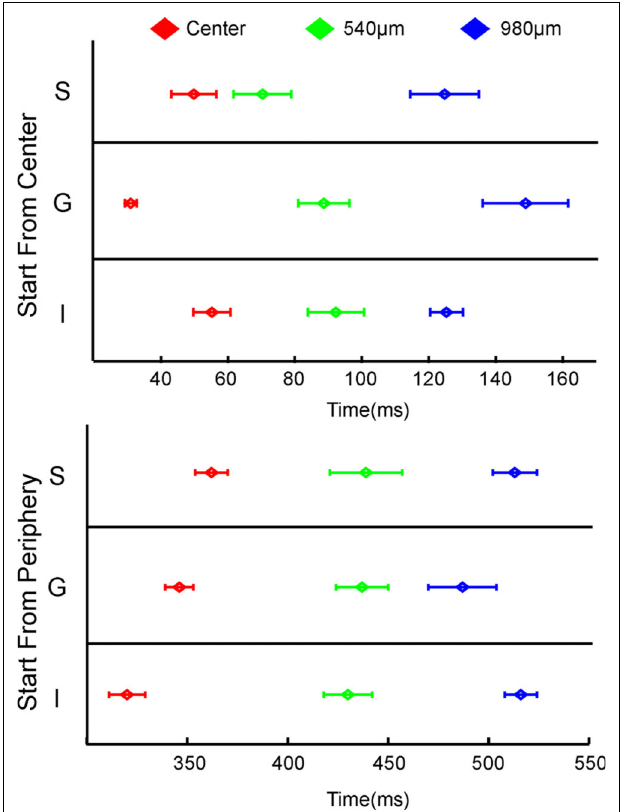
FIGURE 3 | Statistically signifi cant laminar onsets of MUA at three cortical sites. At each site along the 17/18 border, the statistically defi ned onset of fi ring for the fi ve leads corresponding the supragranular (S) layers, the three leads corresponding to the granular (G) layers and the fi ve leads corresponding to the infragranular (G) layers were pooled to give a mean S, G, and I onset for each animal. The mean and SEM for all 11 animals are shown. Note that these values were taken from both upward and downward movement conditions, i.e. the data points at 540 µm are taken from recordings 540 µm lateral to the center for upward bar motion and 540 µm medial to the center for downward bar